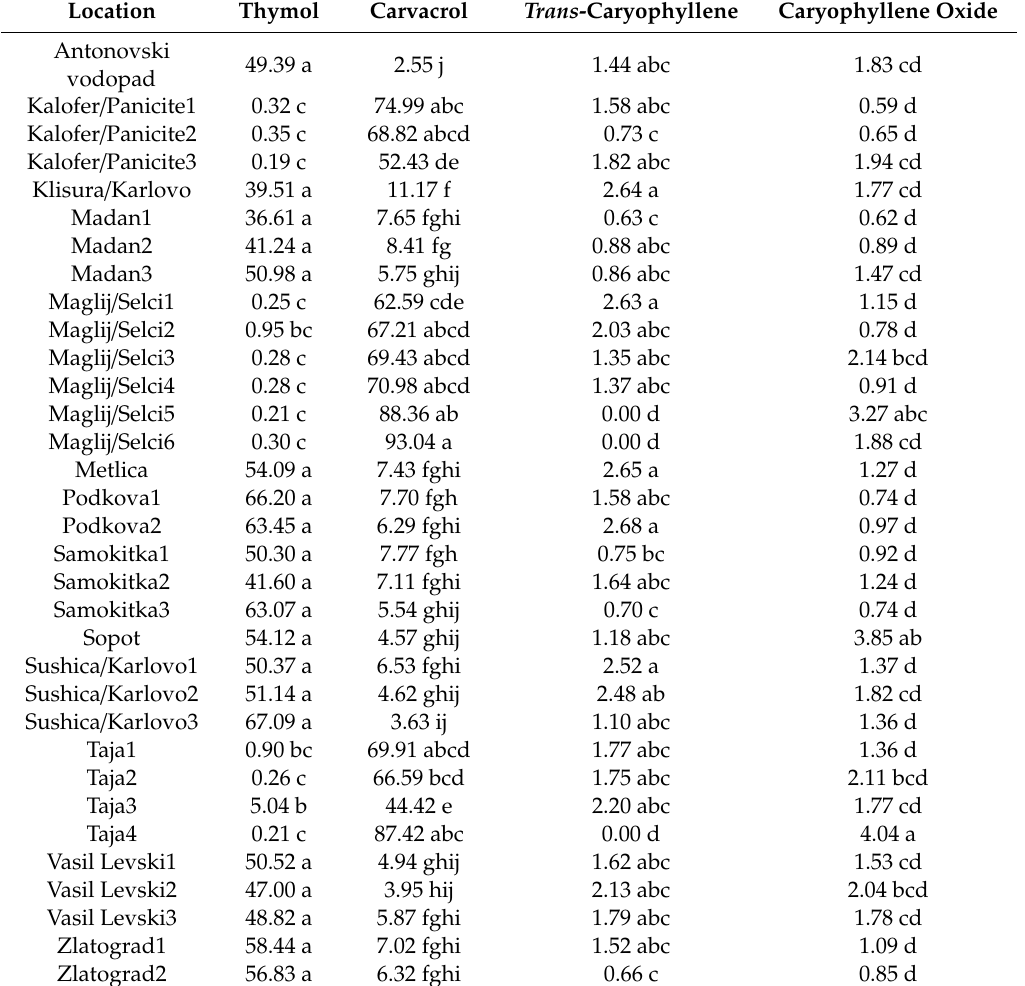
Table 3. Percent composition of thymol, carvacrol, trans -caryophyllene, and caryophyllene oxide (major Satureja pilosa constituents) collected at 33 locations.